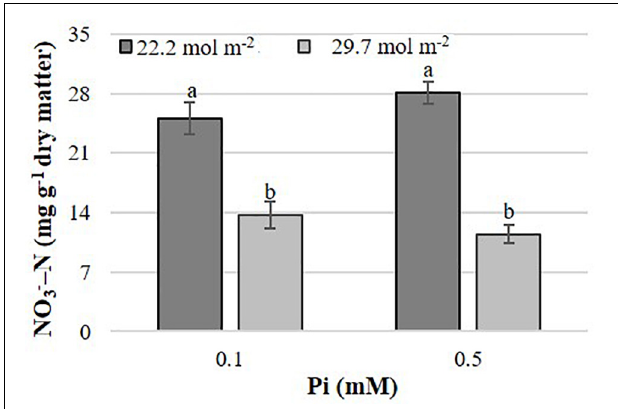
FIGURE 5 | Effects of mean daily photosynthetically active radiation (PAR) and phosphate (Pi) on nitrate concentration in B. campestris cv. Mibuna Early. Means ± SD with different letters indicate significant differences at P ≤ 0.05 (Tukey’s test).